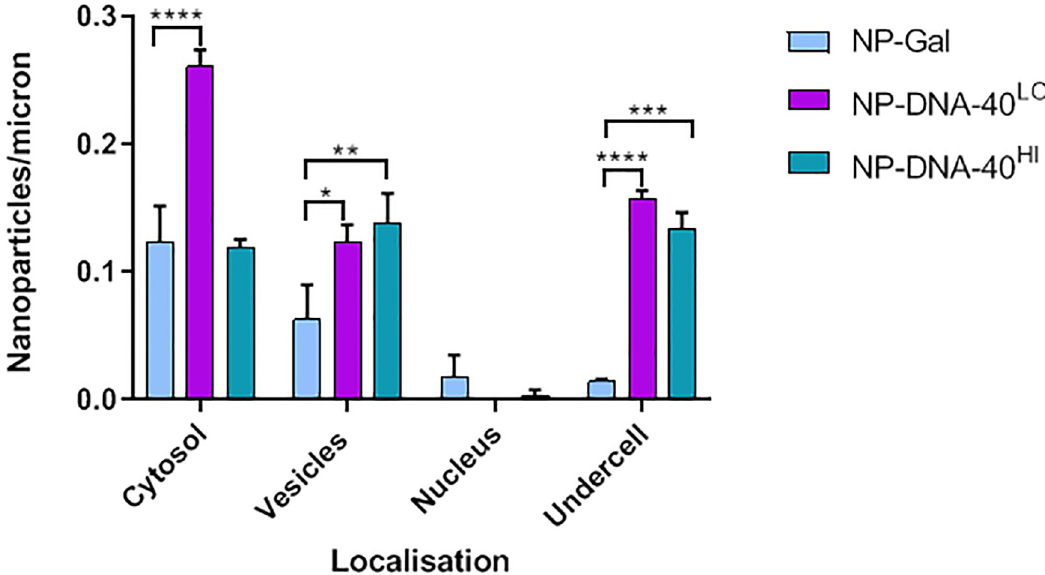
Fig 4. Endocytosis and transcytosis of nanocarriers with high or low levels of dsDNA cargo. Nanoparticles with high or low levels of 40nt dsDNA located in cytosol, vesicles and nucleus of hCMEC/D3 cells and beneath the basal membrane (undercell). Three experiments were performed, each individual experiment having three technical repeats. Tukey’s multiple comparisons test showed significant difference for NP-DNA-40 Lo in cytosol, vesicles and “undercell” compared to NP-Gal ( ���� P < 0.0001: ��� P < 0.001; �� P < 0.01, � P < 0.05).